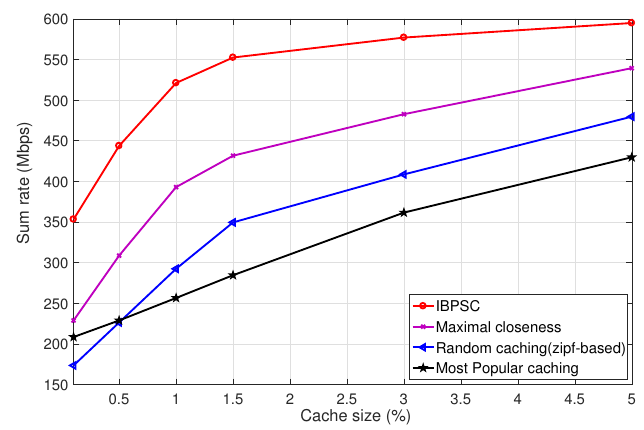
Figure 6. Sum rate vs. cache